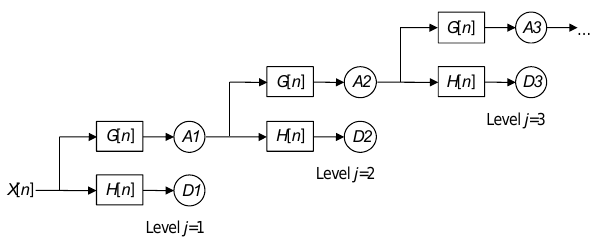
Figure 2 Process of the discrete wavelet decomposition following the Mallat decomposition algorithm. X [ n ] is a discrete signal with n samples, passing though a low-pass filter G and a high-pass filter H with impulse responses of G [ n ] and H [ n ], respectively. A1 , A2 , A3 and D1 , D2 , D3 are the decomposed approximations and details on level j = 1, 2, 3….